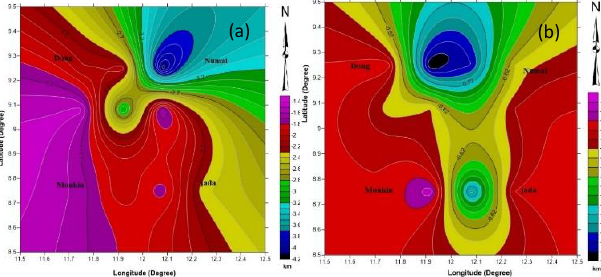
Figure 6: (a) Contour map of the deeper depth of the Study area, (b) Contour map of the shallow depth of the study area